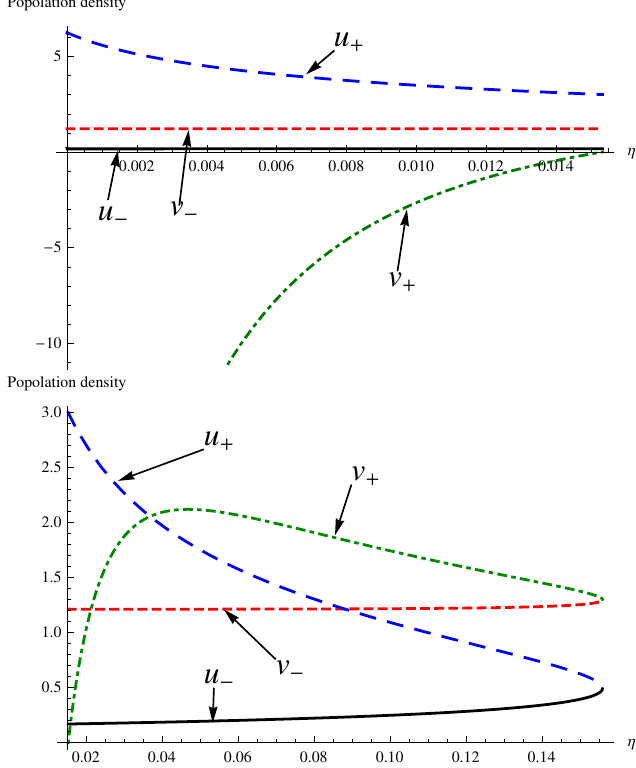
Figure 1. The existence of positive equilibrium with parameter η .